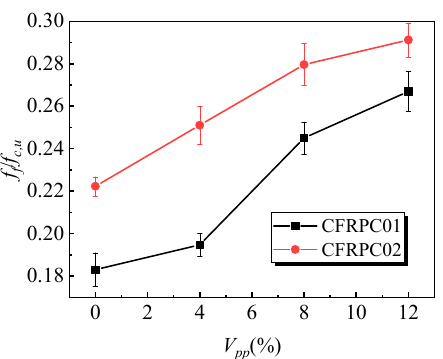
Figure 8. Effect of the polymer–cement ratio on the flexural–compressive ratio of the specimens.